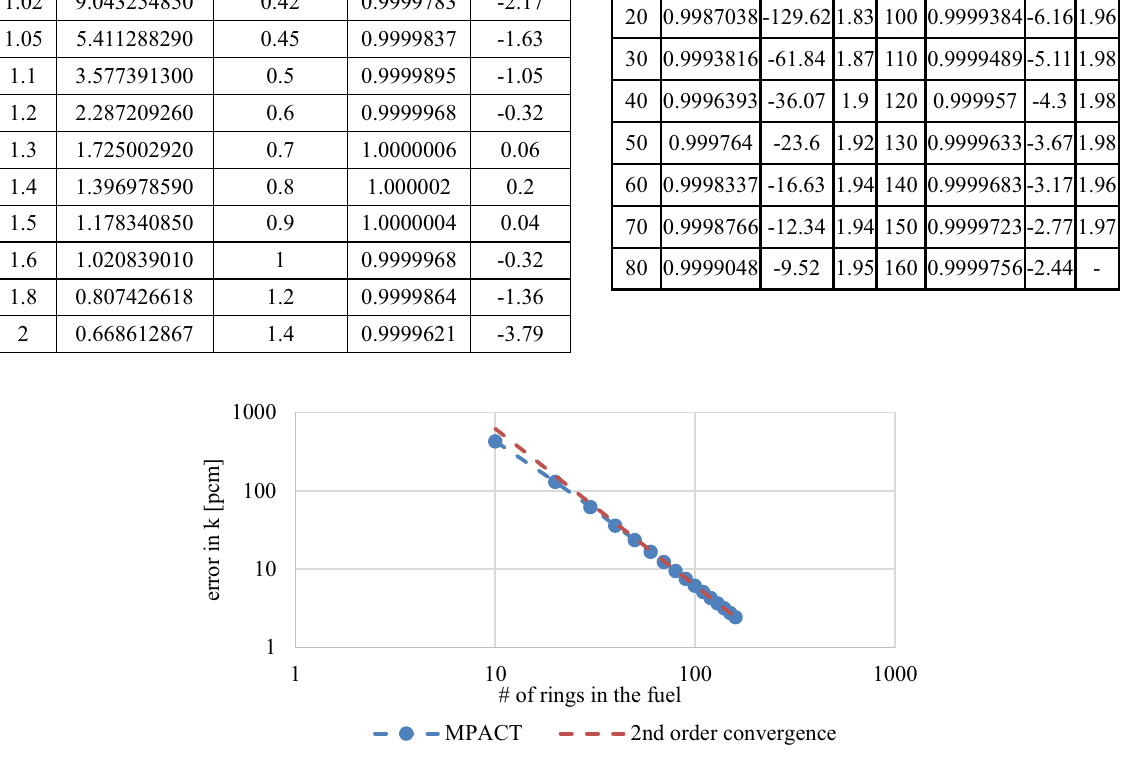
Figure 3. Ganapol radial